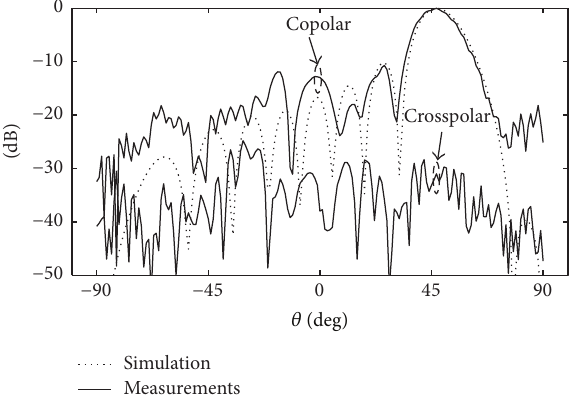
Figure 27: Comparison between measured and simulated radiation